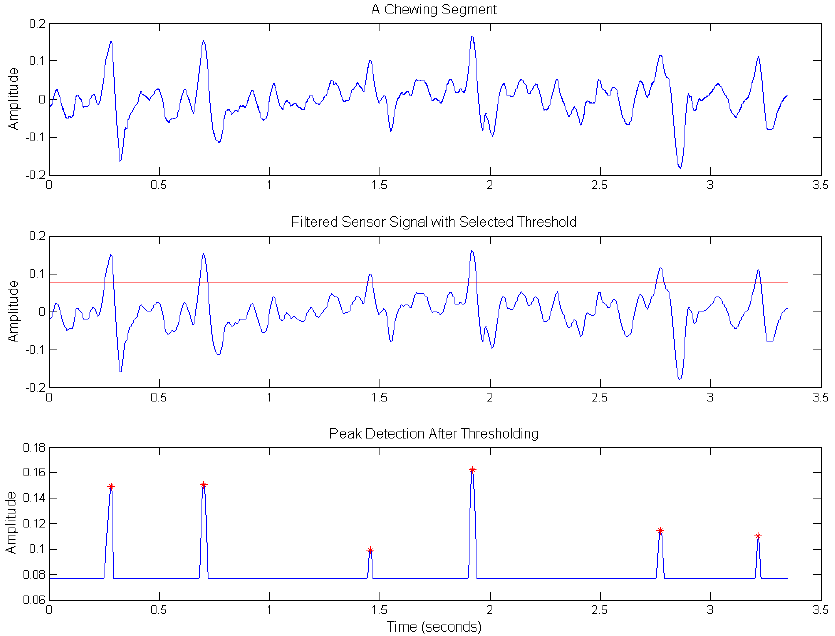
Figure 4. Different stages of signal processing for peak detection in chew counting algorithm. The first row shows the raw sensor signal. The second row shows filtered signal with selected threshold value (horizontal red line). The third row shows signal after thresholding and smoothing. Detected peaks are indicated by a red ‘*’.